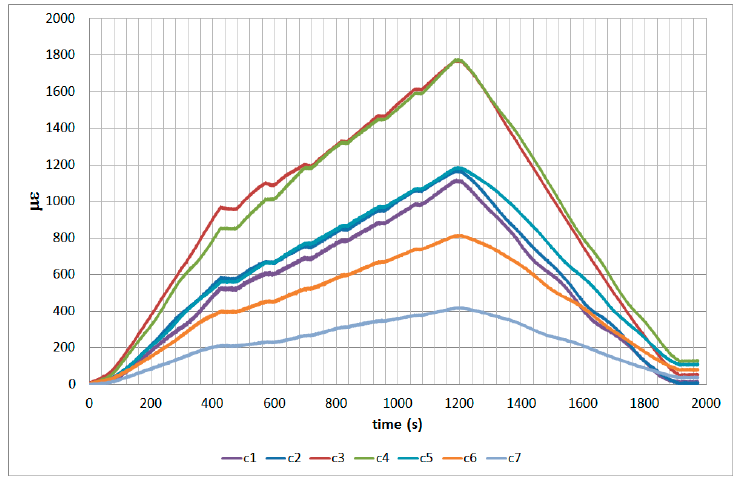
Figure 10. Specimen 1-Root joint -Before fatigue -tensile LL- Channel C.